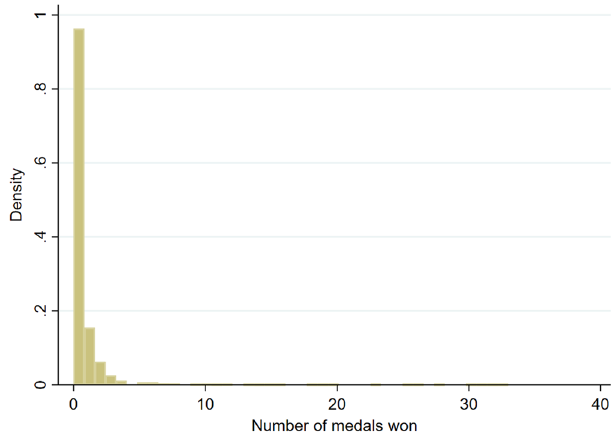
Figure 2. Distribution of total number of medals.